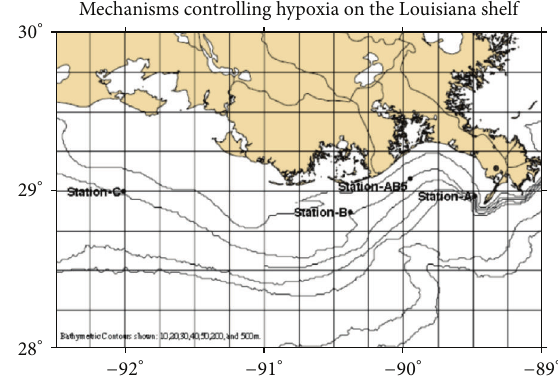
Figure 1: Sampling sites in Gulf of Mexico hypoxic zone on Louisiana continental